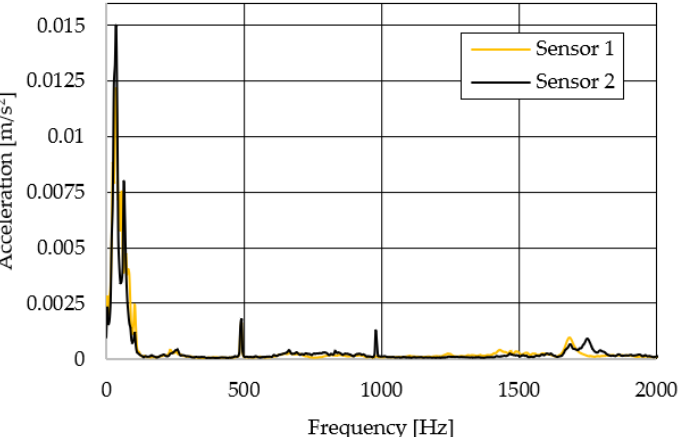
Figure 21. Comparison of the frequency waveforms in the y -axis during asymmetrical crossing over the obstacle by the left wheel.